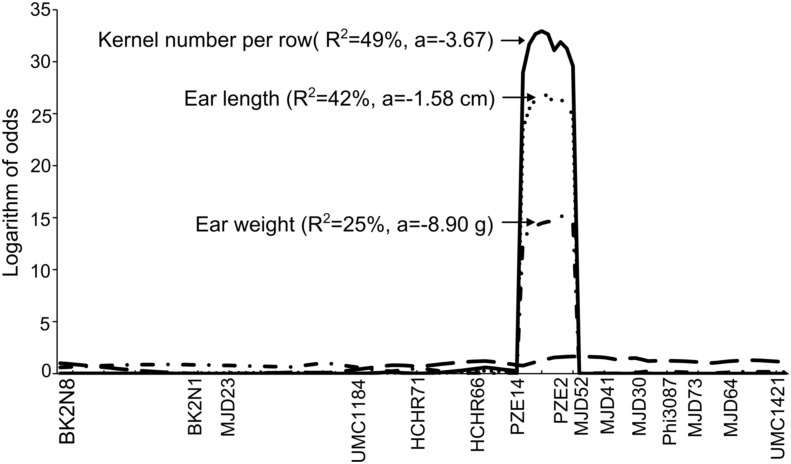
Remapping of qEL1.10 using a near isogenic line-derived mapping population.